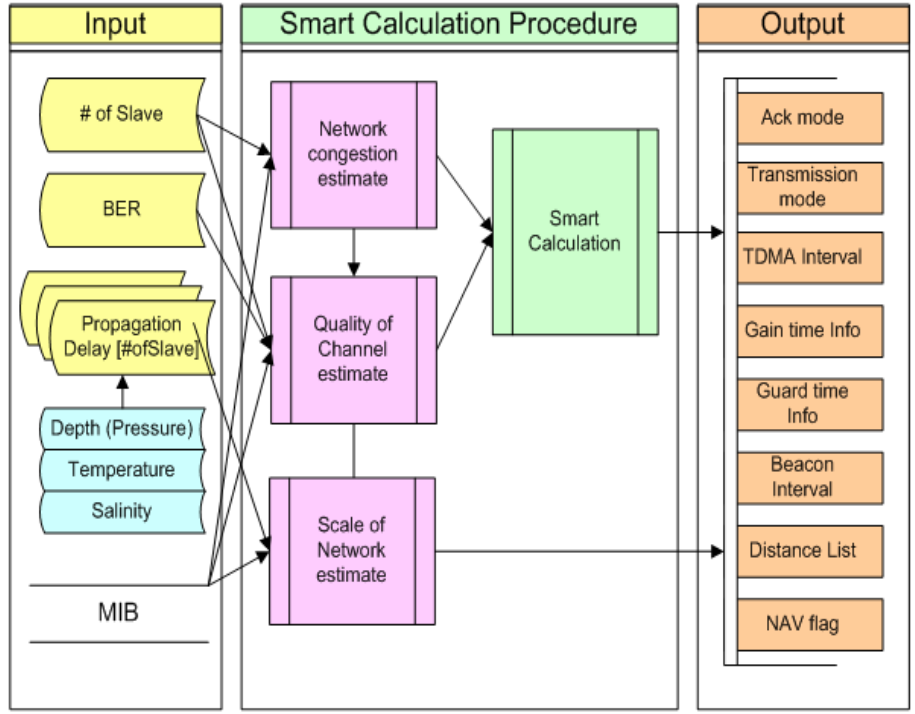
Figure 5. Smart Calculation Procedure of